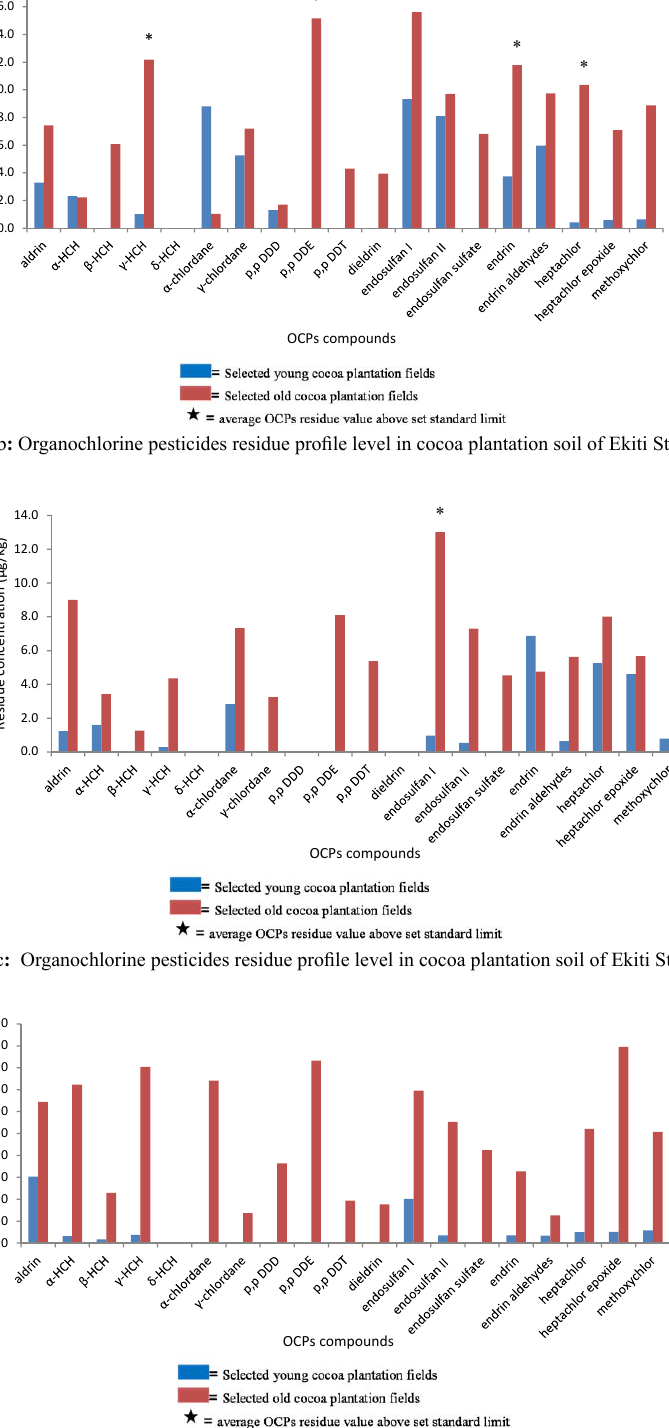
Fig. 2a : Organochlorine pesticides residue profile level in cocoa plantation soil of Edo State.